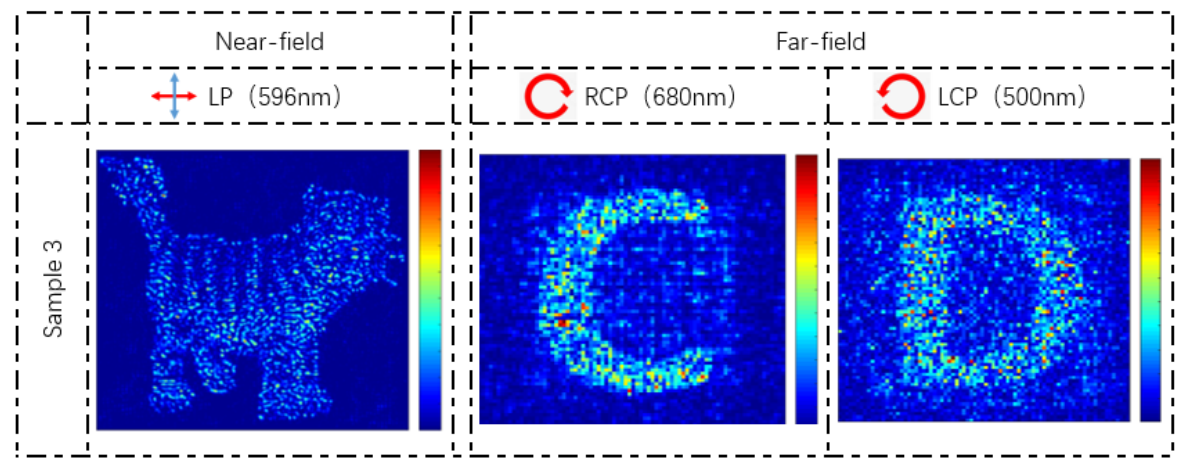
Figure 10. The simulation results of the holographic images under RCP at 680 nm and LCP at 500 nm.